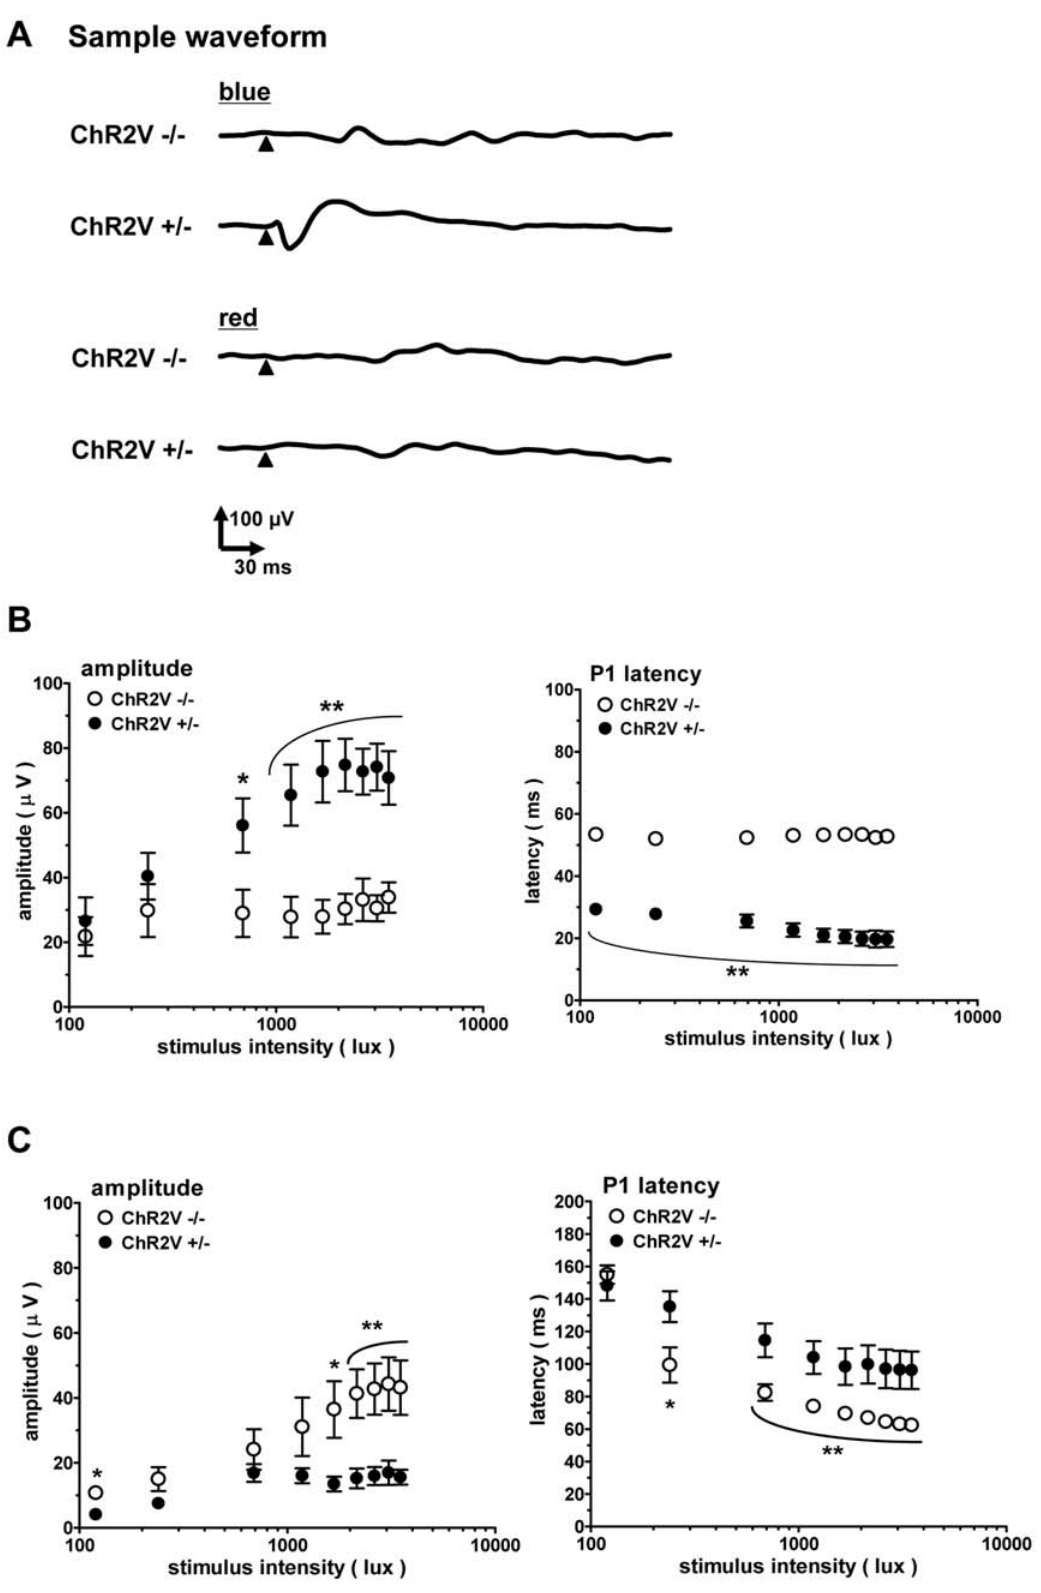
Figure 7. The VEPs after photoreceptor degeneration. (A)Sample waveforms evoked by blue or red LED flash. (B) The amplitude- (left) and the latency- (right) stimulus intensity relationships of VEPs evoked by the blue LED flash. (C) The summary of VEP responses to the red LED flashes. Error bars represent standard deviation (n=8, *: P , 0.05, **: P , 0.01, unpaired t-test).